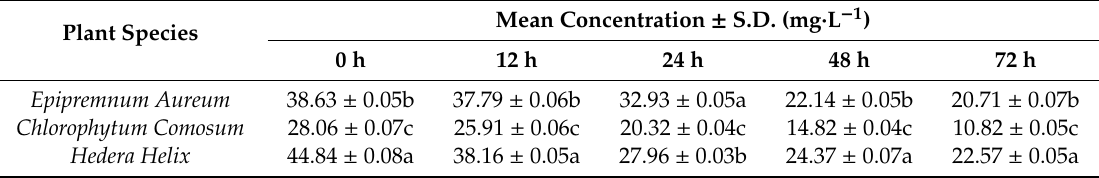
Table 1. Chlorophyll concentration of the three plants under di ff erent exposure times. Plant Species